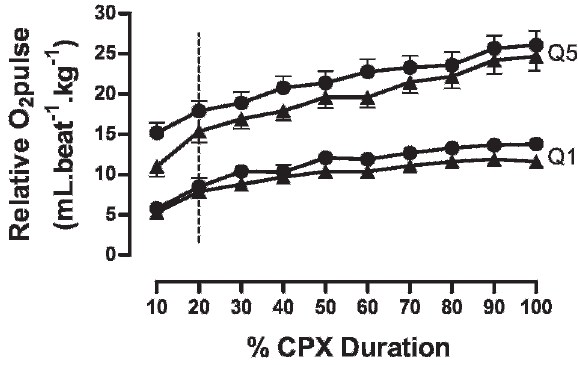
Figure 1 - First and second quintiles of relative O 2 pulse during CPX. Triangles ( m ) stand for results obtained in the first CPX. Closed circles ( $ ) stand for results obtained in the second CPX. The vertical line highlights the linearity of the curves after exclusion of the first 10% of the CPX time. All results of relative O 2 pulse were multiplied by 100. The exercise responses and slopes for each quintile are shown in tables 3 and 4. Q, quintiles; CPX, cardiopulmonary exercise testing. No significant differences were found when both CPX in each quintile were compared (p . 0.05 for